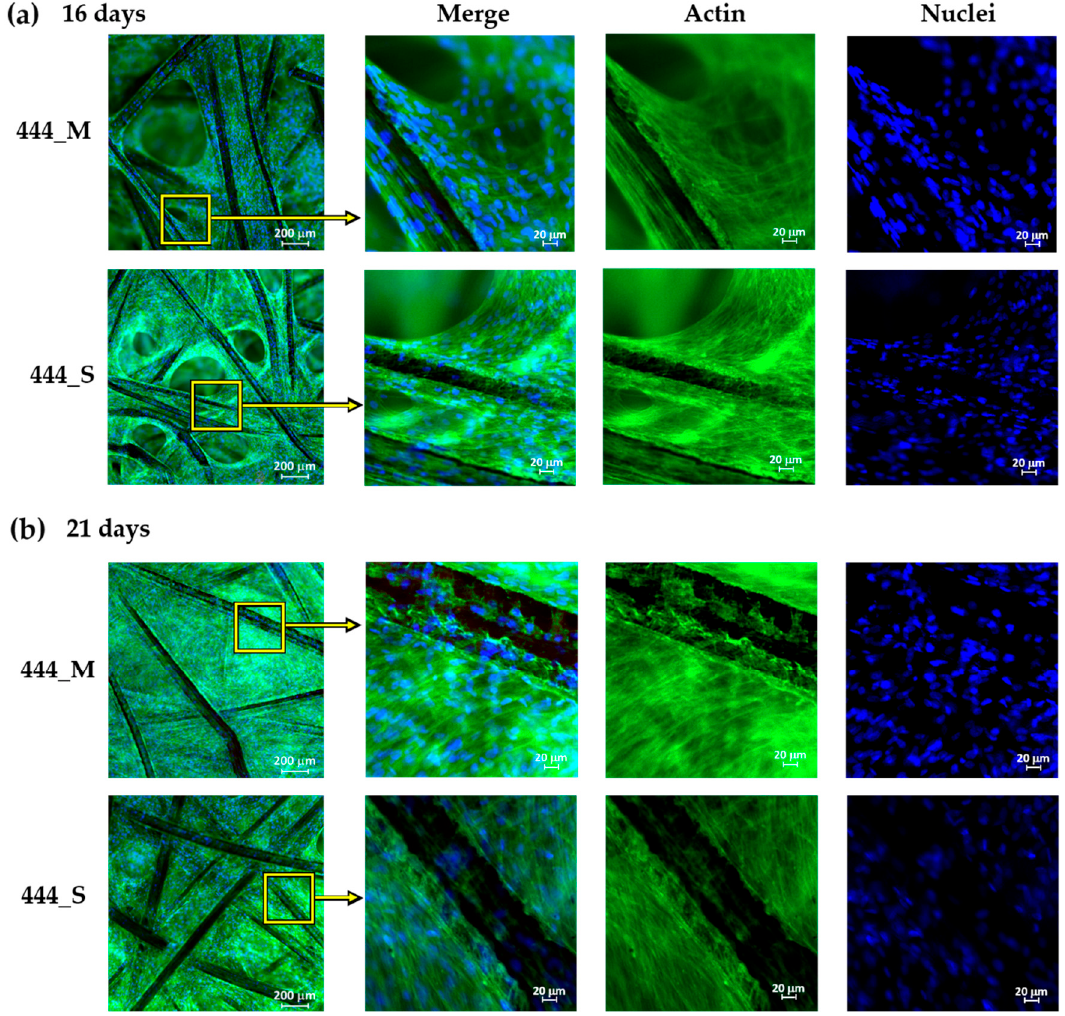
Figure 3. Representative immunofluorescence images showing magnetically-actuated (M) and static (S) 444 fiber networks on day ( a ) 16 and ( b ) 21 of culture. FITC-phalloidin and DAPI were used to stain the actin cytoskeleton green and the nuclei blue, respectively.